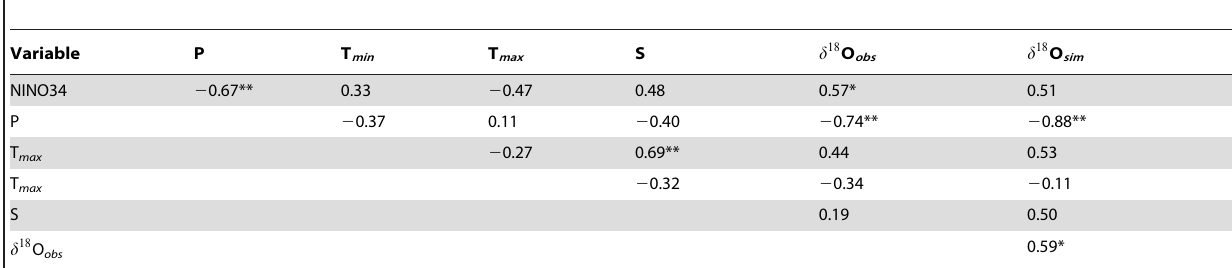
Table 3. Correlation between climatological data, composite median d 18 O and simulated median d 18 O.